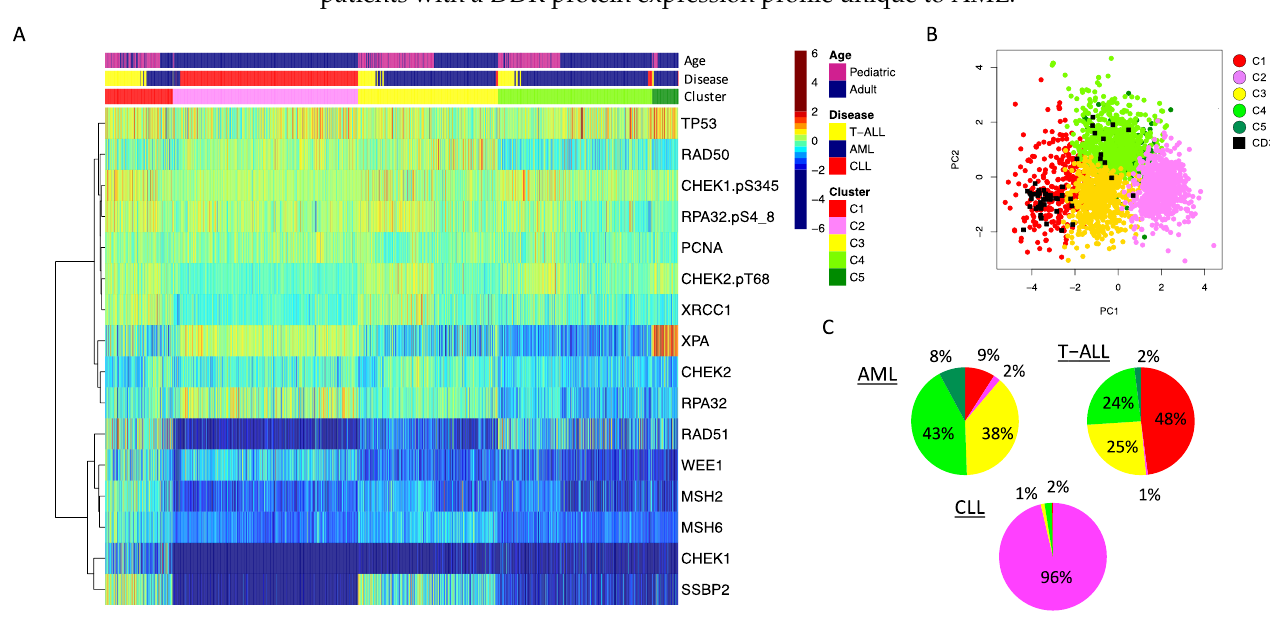
Figure 2. DDR protein expression in leukemia. ( A ) The heatmap shows protein expression scaled relative to normal bone marrow-derived CD34+ cells (scaled from high = burgundy, normal = green, low = blue) in 2466 leukemia patient samples. Annotations show: top row: age (pink = pediatric (age < 18 years), blue = adult (age ≥ 18 years)), middle row: disease: blue = AML, red = CLL, yellow = T-ALL. Unbiased hierarchical clustering followed by progeny clustering defined five different clusters, shown in the third row of the annotations. ( B ) The principal component graph shows that the normal CD34+ samples, shown as a black square, overlap with protein cluster 1 (red) and protein cluster 4 (green). ( C ) Pie charts showing the distribution of cluster membership for the AML, T-ALL and CLL patient samples. Colors align with the colors used in the annotation bar of the heatmap shown in A.